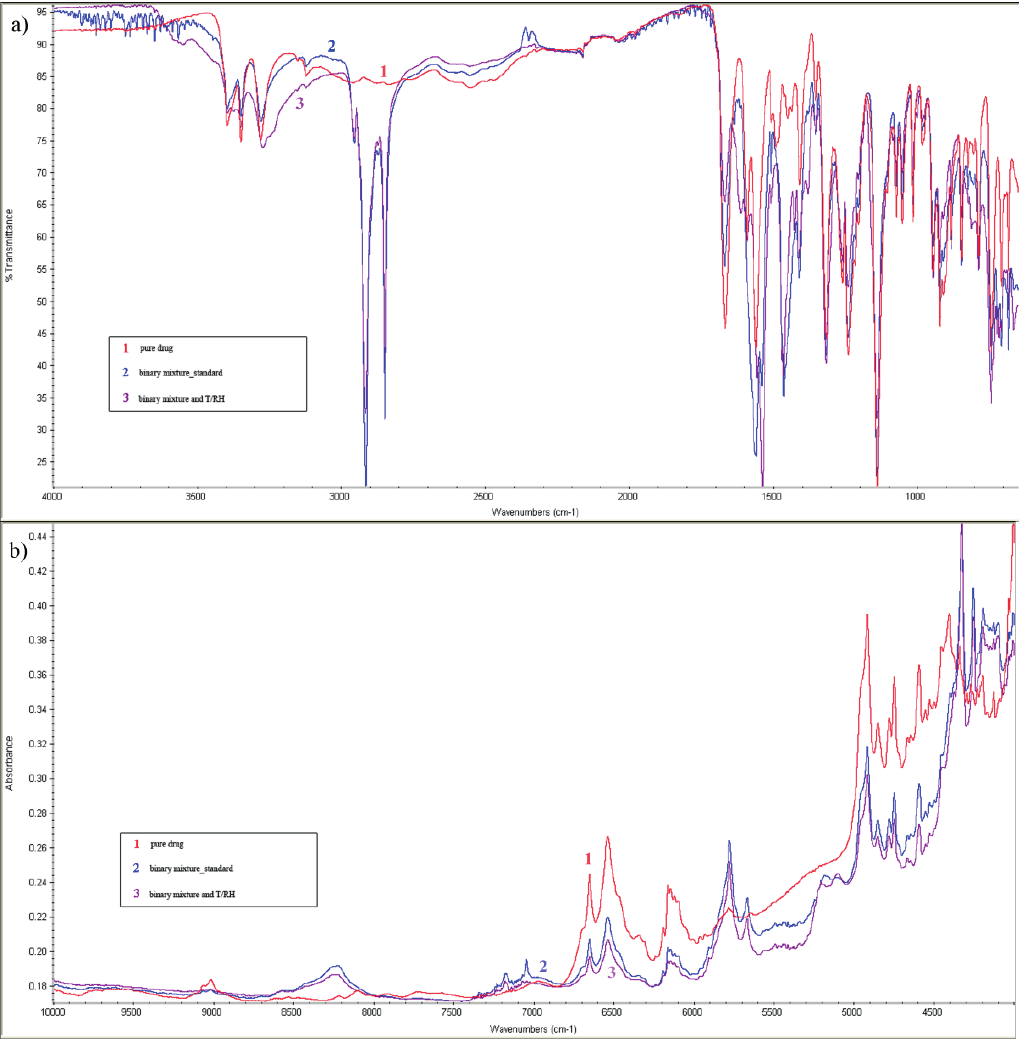
Figure 9 : Furosemide and Mg stearate: FT-IR spectra (a) and NIR spectra (b) for the mixture stressed with high temperature/humidity (T/RH) and the untreated mixture (standard) against pure